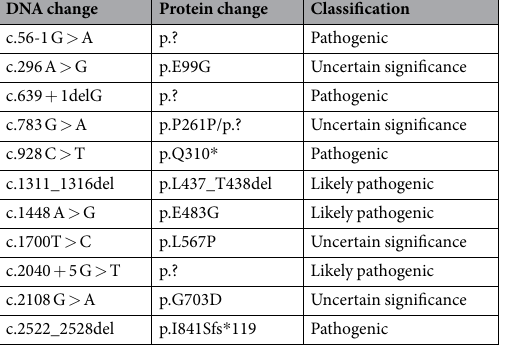
Table 2. Classification of all CDHR1 variants identified in this study according to ACMG